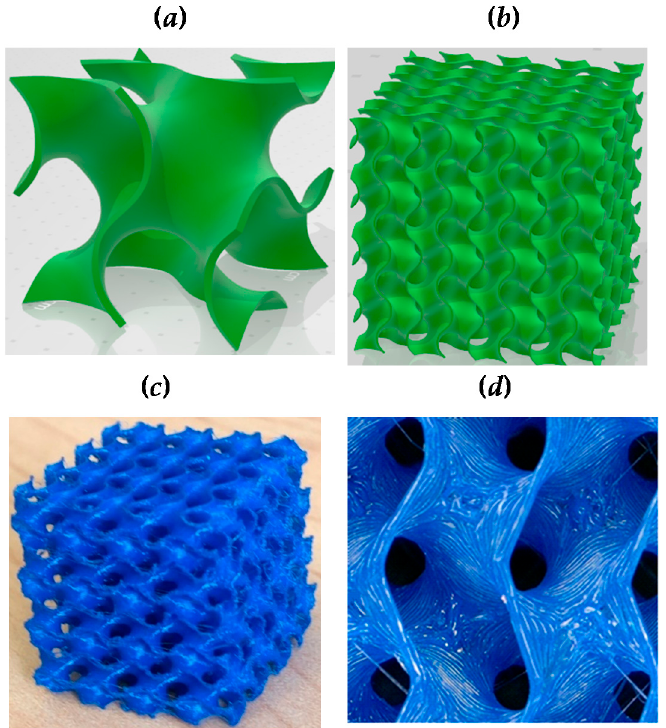
Figure 1. The 3D-printed scaffold-based porous structure: ( a ) unit-cell; ( b ) scaffold; ( c ) 3D-printed porous structure; and ( d ) the magnified view of the structure shown in ( b ).